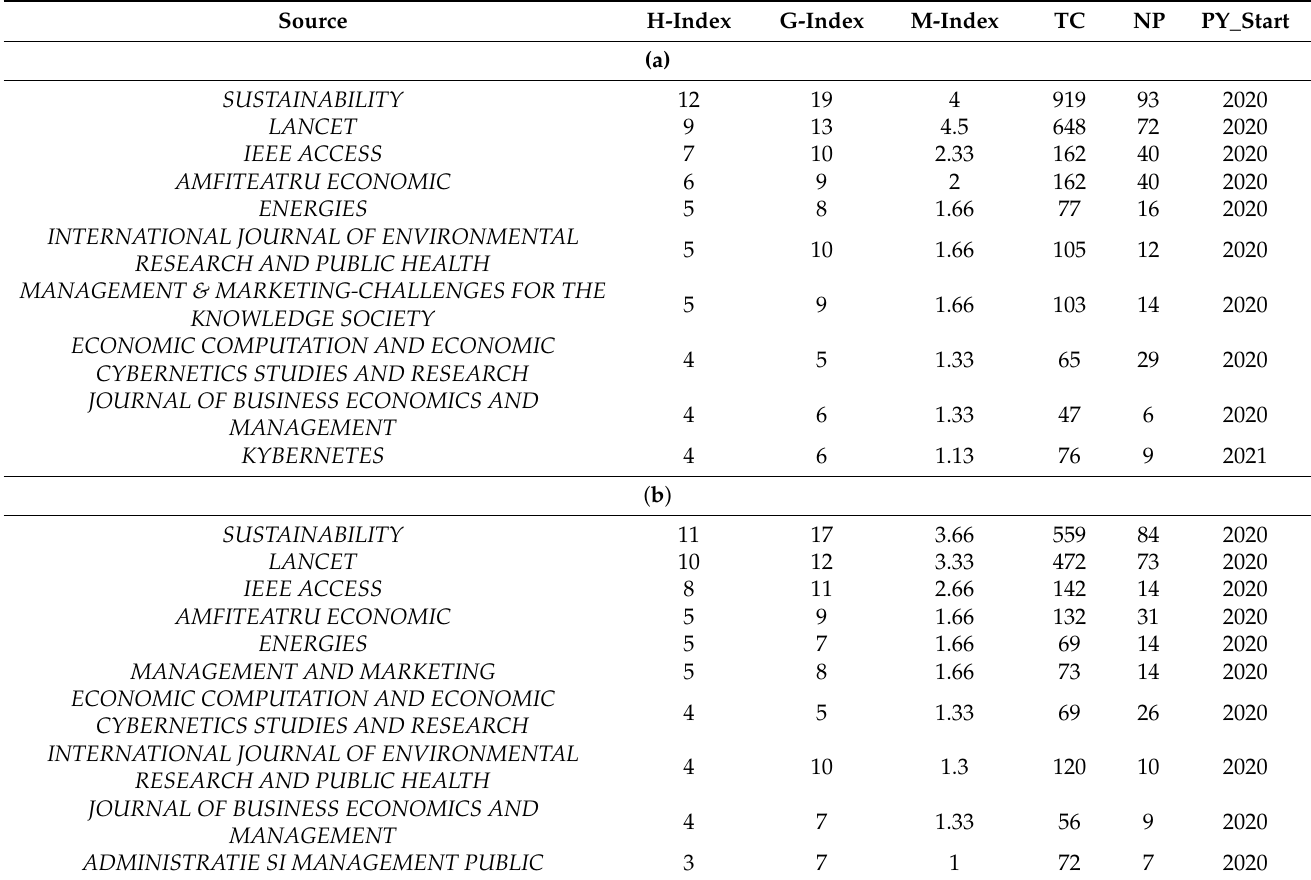
Table 3. Most important sources. ( a ) WoS. ( b )